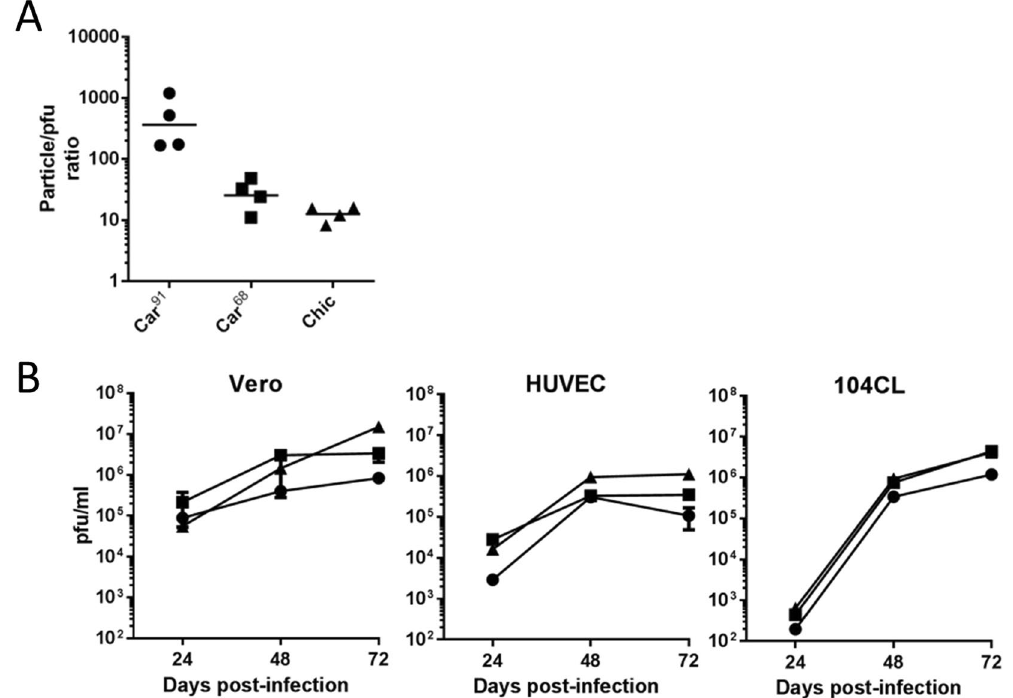
Figure 4. In vitro characterization of Car 91 , Car 68 and Chic. ( A ) Particle-to-pfu ratios for each of the indicated MACV strains were determined using a ViroCyt system. Four virus preparations for each virus were tested in triplicate. The geometric means are indicated by the solid line. ( B ) The indicated cell types were infected with Car 91 (circles), Car 68 (squares) or Chic (triangles) at an MOI of 0.1 and replication was quantitated at 24, 48 and 72 hpi by plaque assay. All samples were titered in duplicate and the mean + / − SD were